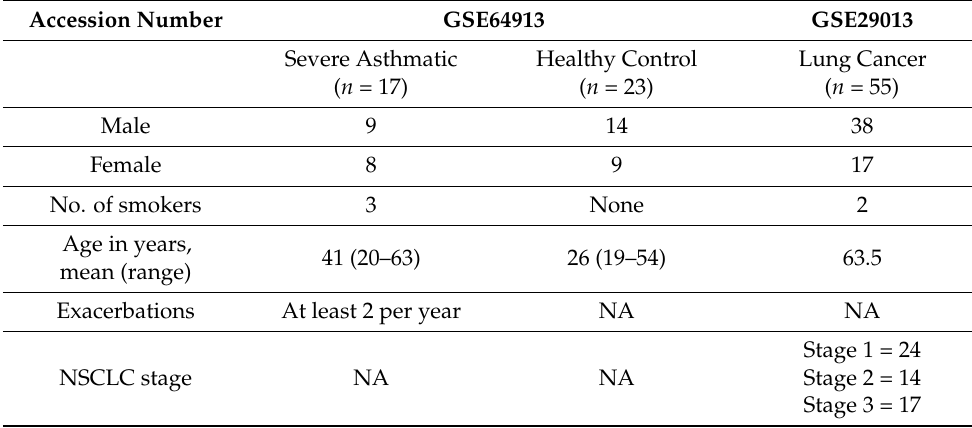
Table 1. Details on the samples and the subjects retrieved from the